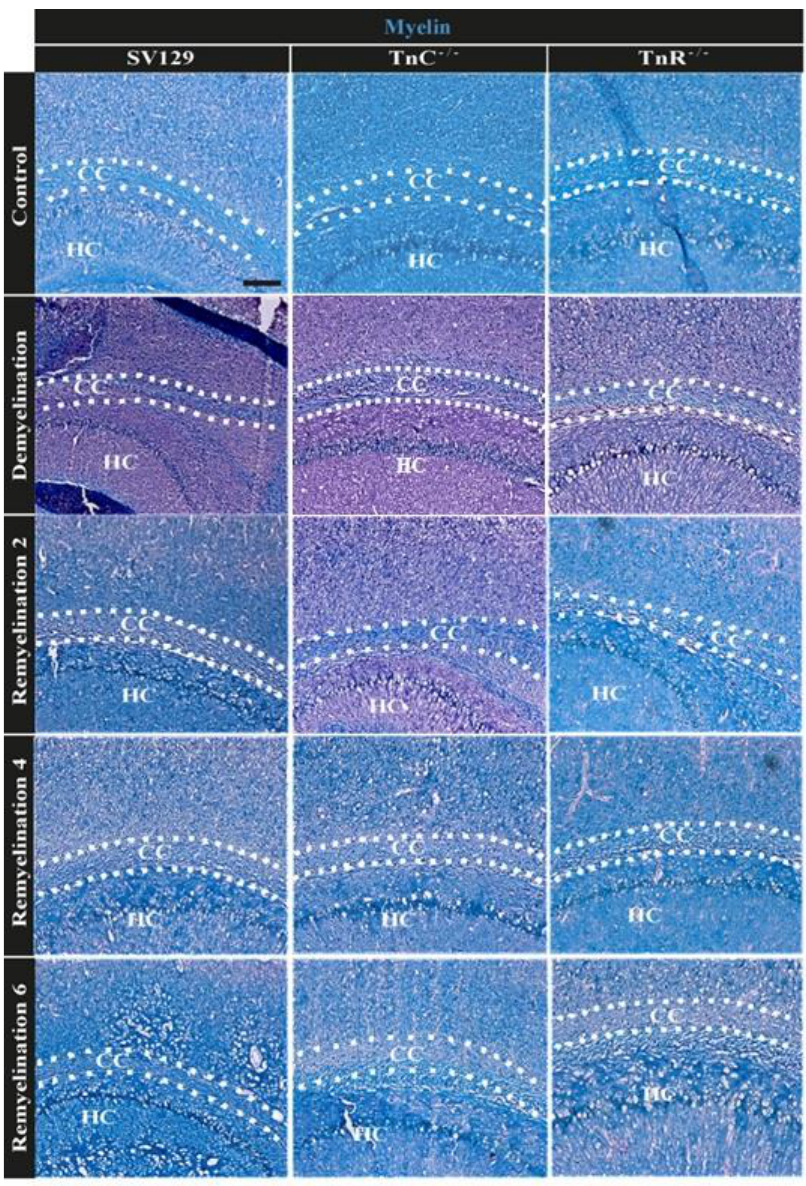
Figure 2. LFB-PAS staining for comparing myelin in the corpus callosum of 129/SV-wildtype, Tnc − / − and Tnr − / − mice under control, demyelination, and remyelination conditions. Cryosection of 129/SV wild-type, Tnc − / − and Tnr − / − mouse brains were immunohistochemically stained with LFB-PAS in control (C), demyelination (DM), and 2-, 4- and 6 weeks of remyelination (RM2, RM4, and RM6) condition. Myelin was stained blue with LFB, and axons were stained pink via PAS. After 10-weeks of cuprizone administration the blue staining was strongly reduced, indicating efficient removal of myelin. Blue labeled recovered progressively with myelin regeneration, axons were labeled in pink. Cuprizone-induced demyelination as well as remyelination after withdrawal was obvious for the three genotypes. Scale bar 200 µm (N = 1, n ≤ 2 ).